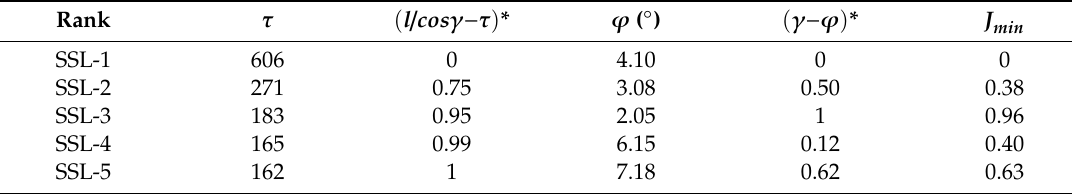
Table 2. The relevant parameters of the cost